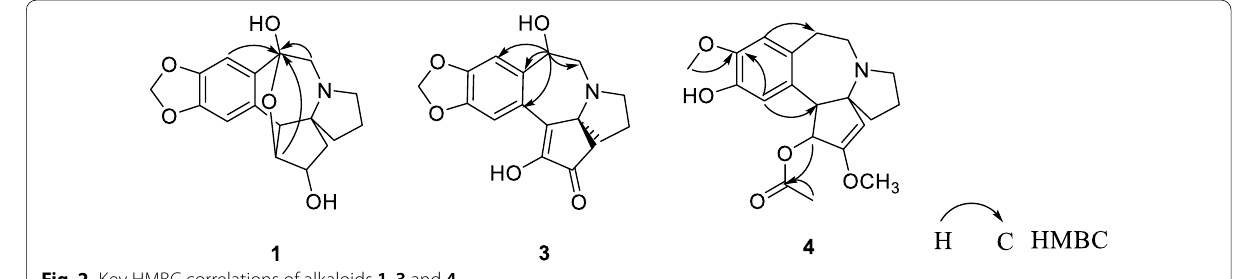
Fig. 2 Key HMBC correlations of alkaloids 1 , 3 and 4